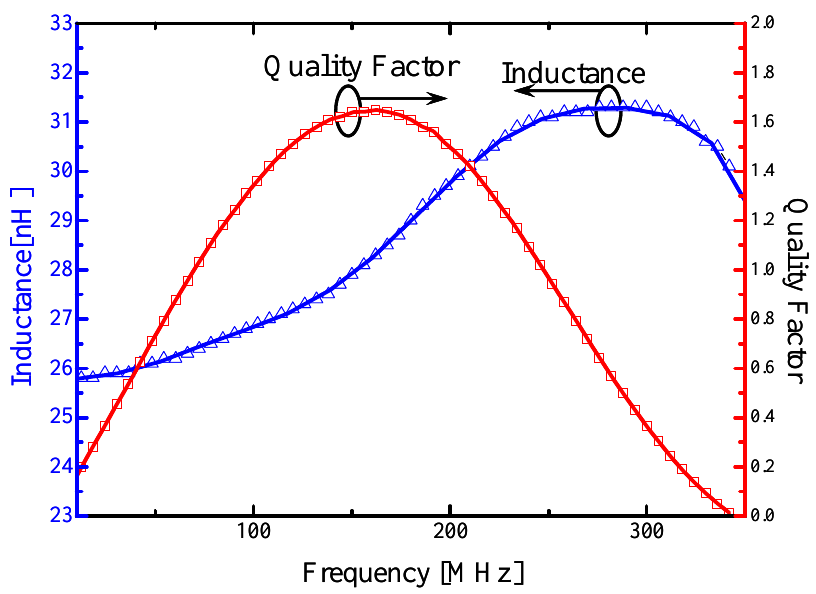
Figure 14. The measured Q and L of a bonding wire